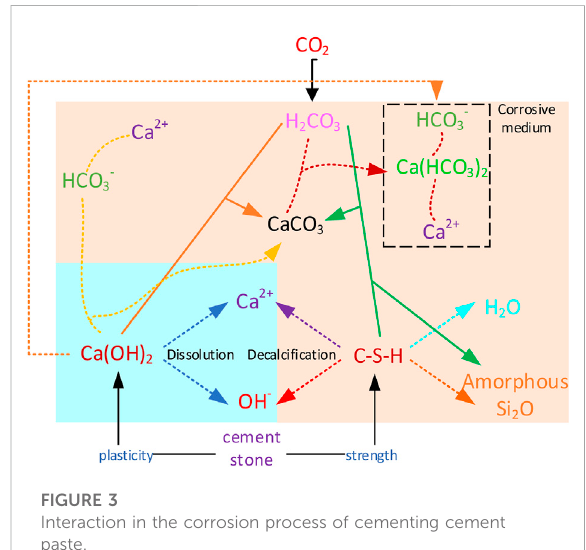
Interaction in the corrosion process of cementing cement